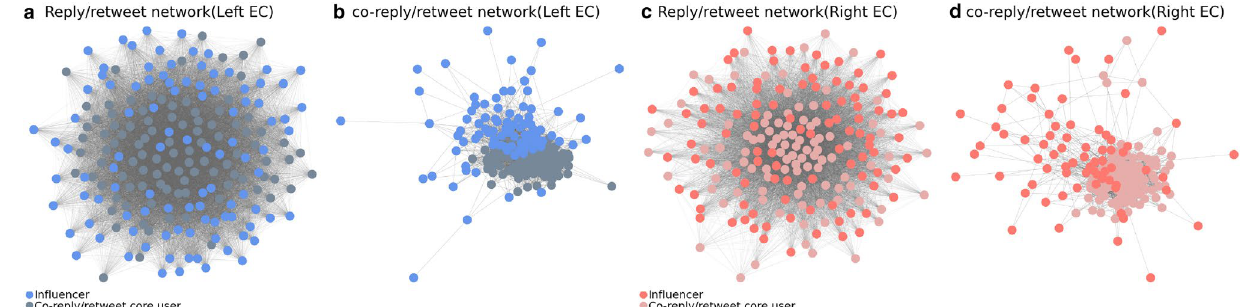
Figure 4. Network visualisation of the top 100 influencers (blue/red) and co-reply/retweet core users (light dark blue/dark red) of the EC communities: ( a ) Reply/retweet network of left EC. ( b ) The largest connected component of co-reply/retweet network of the left EC. 11 top influencer is not included in the component. ( c ) Reply/retweet network of right EC. ( d ) The largest connected component of co-reply/retweet network of the right EC. 30 top influencer are not included in the